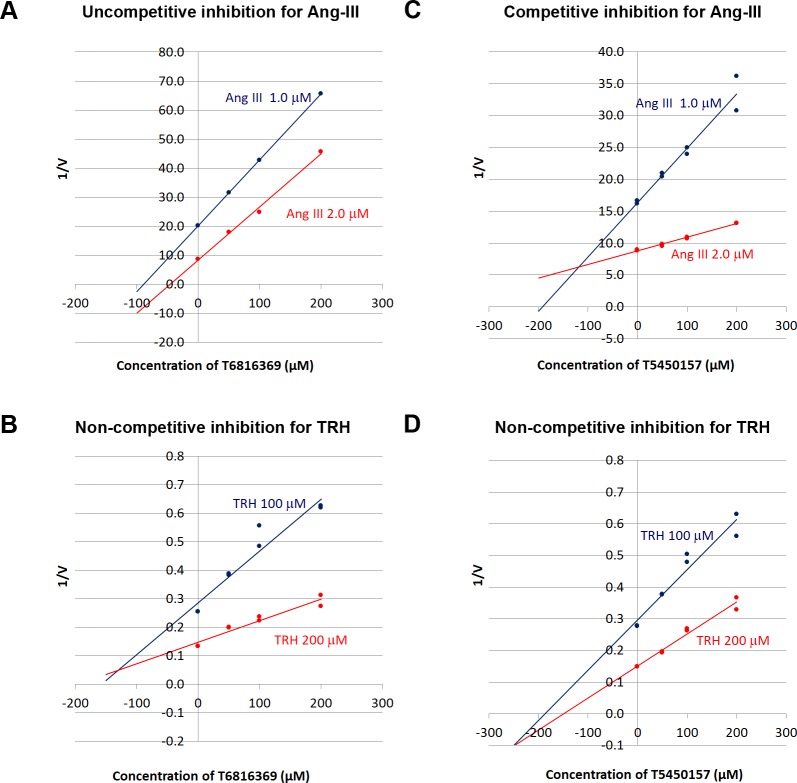
Dixon plots of: A) Ang-III cleavage in presence of T6816369; B) TRH cleavage in presence of T6816369; C) Ang-III cleavage in presence of T5450157; D) TRH cleavage in presence of T5450157.